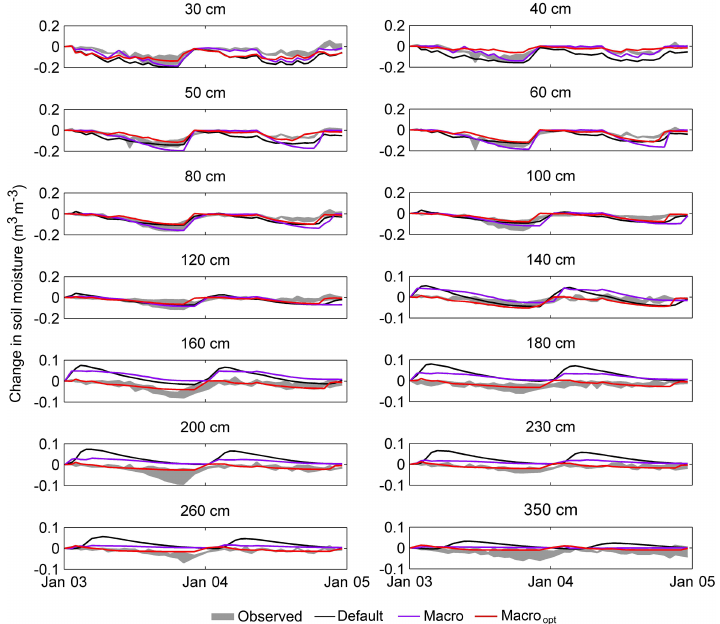
Figure 5. Comparison between observed and simulated (cid:49)θ from default, macro and macro opt configurations at various depths below the land surface. The shaded areas, which are constructed from two soil moisture probes at the Warren Farm site, denote the range of (cid:49)θ .